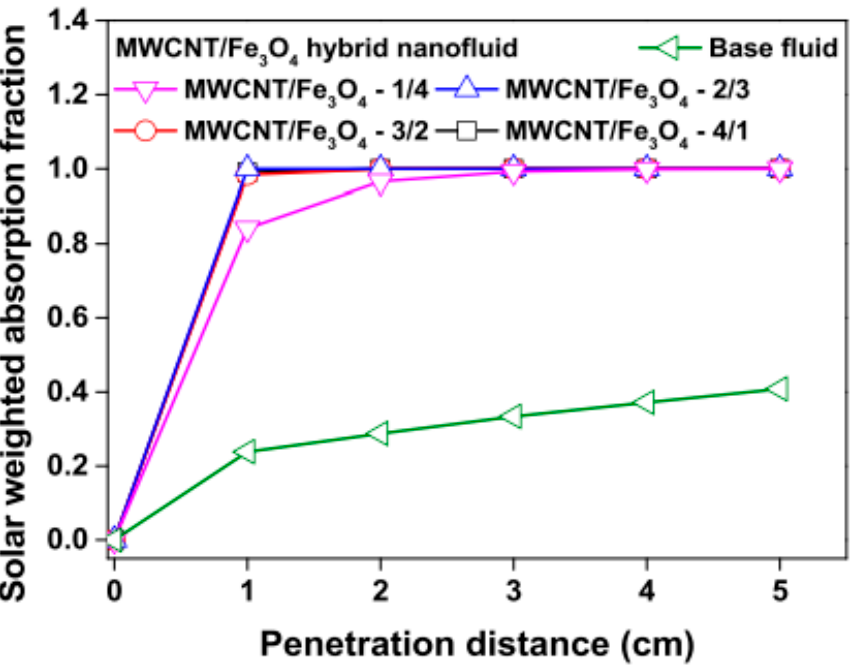
Figure 7. Effect of increasing penetration distance on solar weighted absorption fraction of MWCNT/Fe 3 O 4 nanofluids and base fluid (Adapted from Tong et al. [61]).